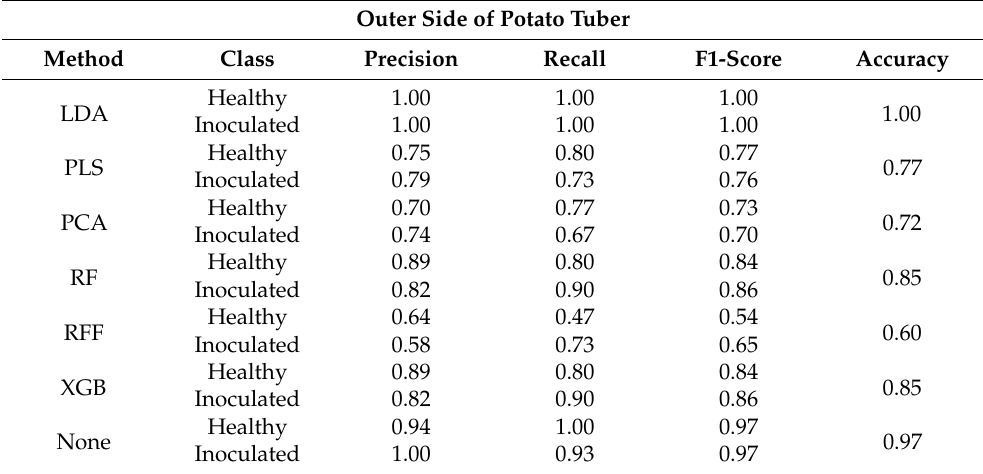
Table 2. Comparison of classification results with only one feature for selected DR methods for inside tuber